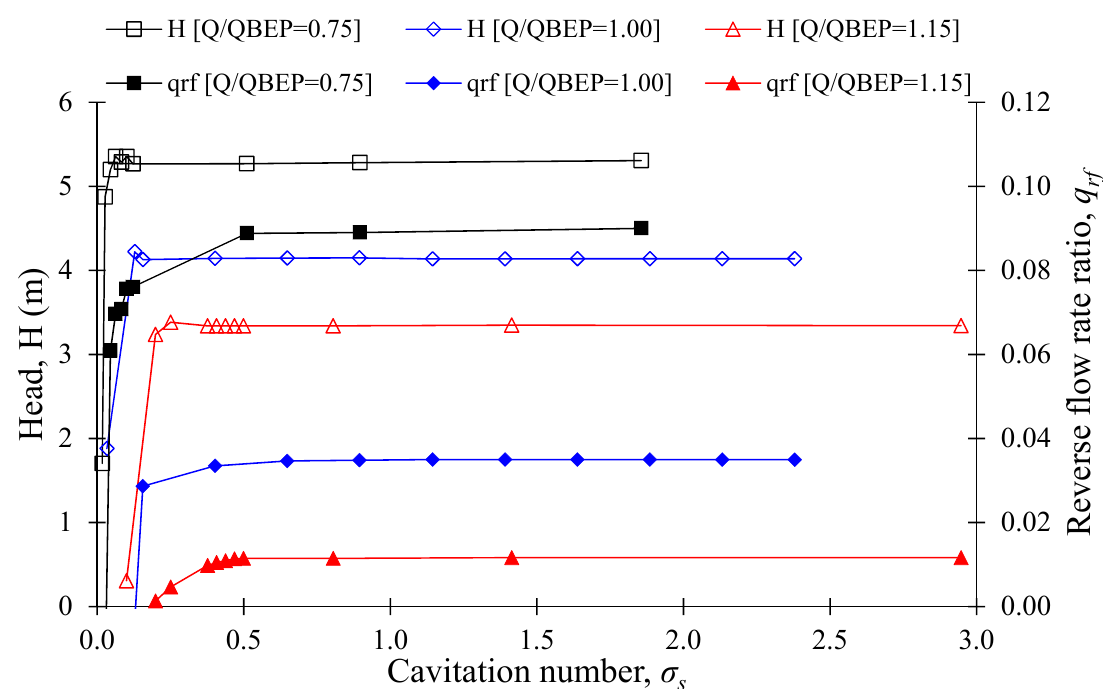
Figure 23. Relationship between suction performance and reverse flow rate in the AJP model with J-Groove.